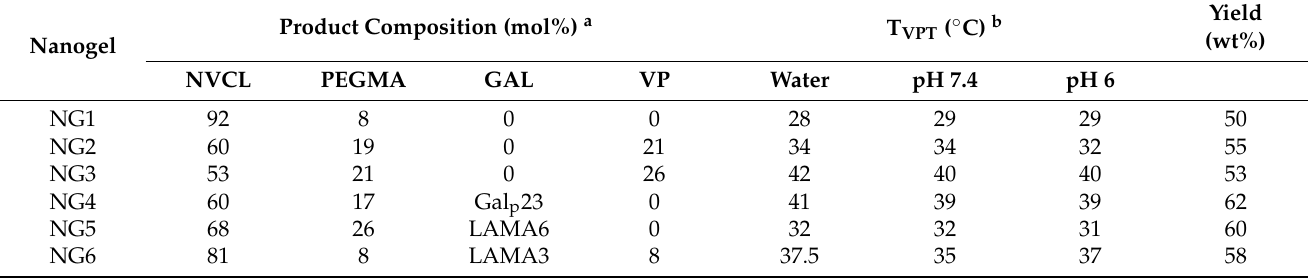
Table 1. Composition of nanogels, transition temperature, and